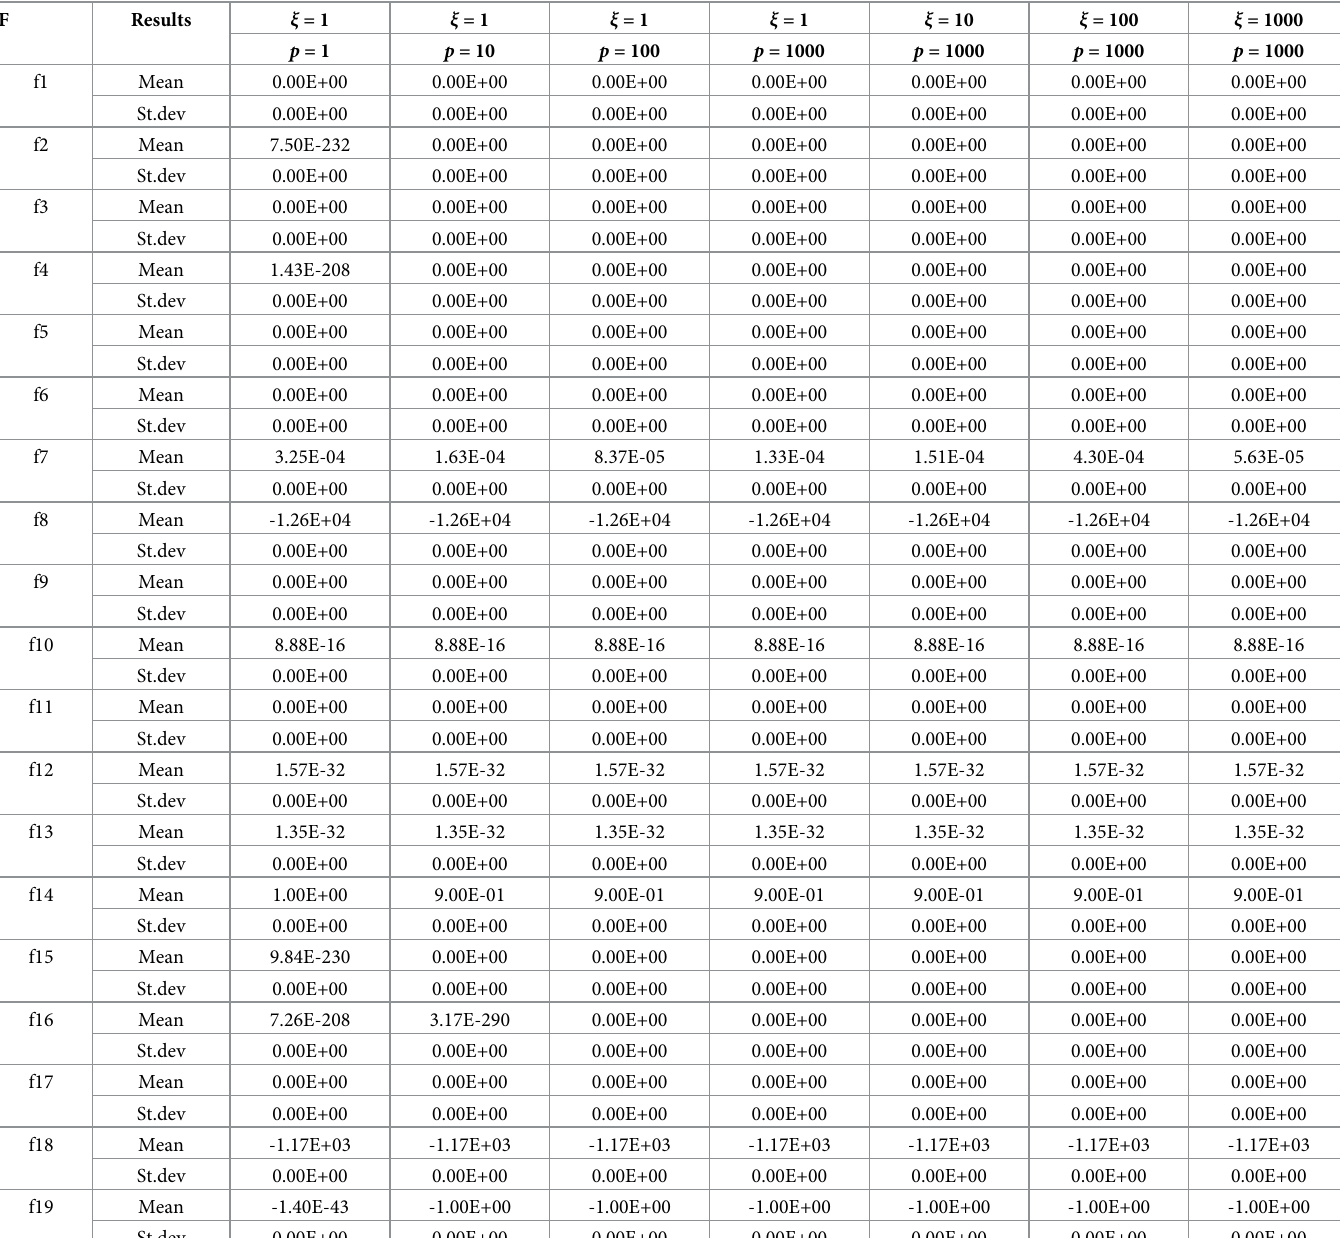
Table 10. Experimental results of CRLPO for 19 test functions with typical combinations of ξ and p(Dim = 30). F